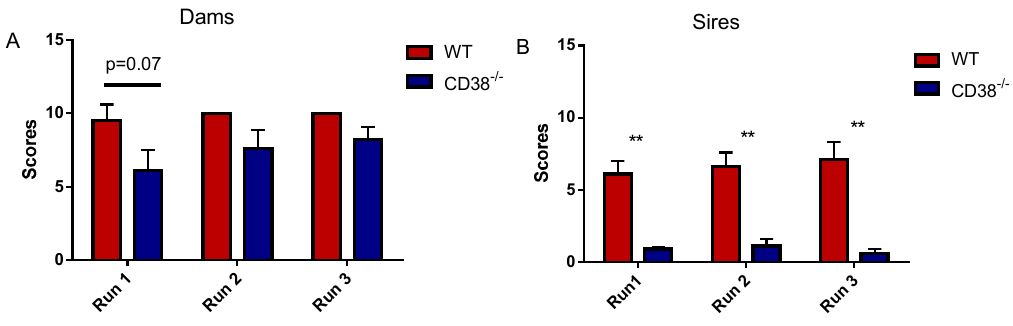
Figure 1. The pup retrieval scores of CD38 +/+ Wild-type(WT) or CD38 − / − dams ( A ) and sires ( B ) in three trials. Ten experiments were conducted for each test. The two-tailed Student t -test was performed for each trial for dams ( p > 0.05 for each comparison between genotypes) and for sires (** p < 0.01 for each comparison).